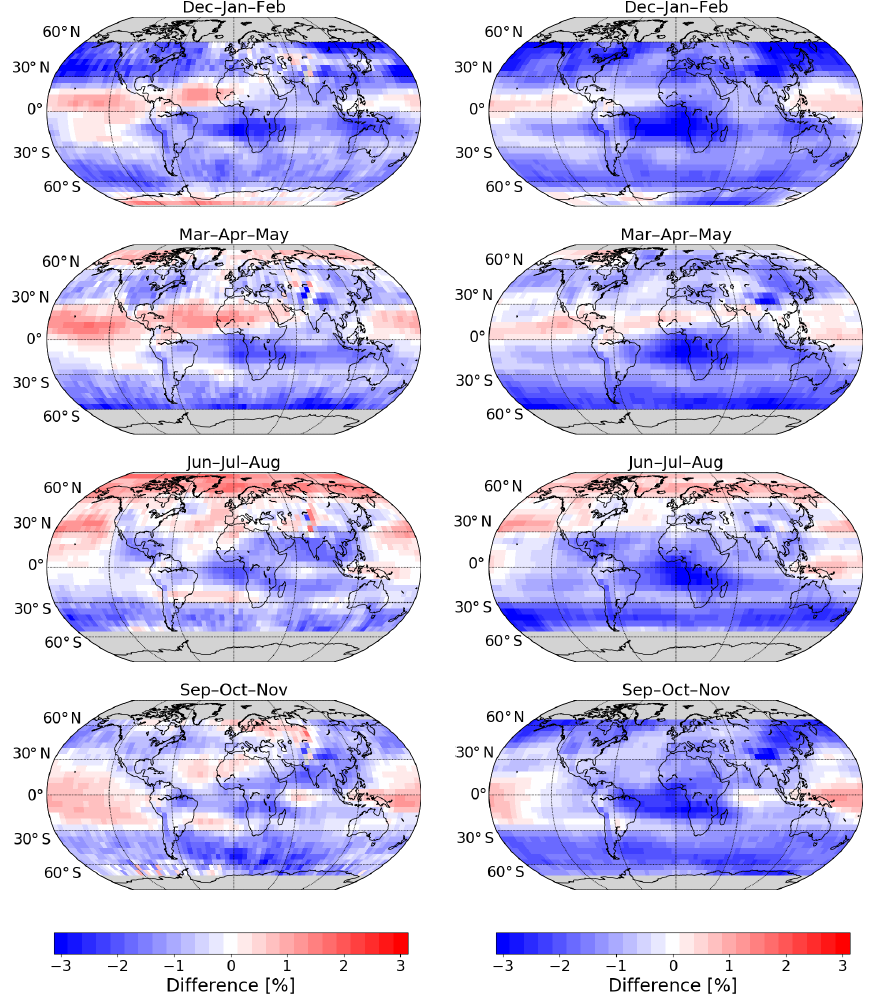
Figure 7. Seasonal mean percentage difference in total ozone columns between adjusted MERRA-2 and GTO-ECV. From top to bottom: December–February, March–May, June–August, and September–November. Panels on the left-hand side correspond to the period 1995– 2004, and panels on the right-hand side correspond to the period